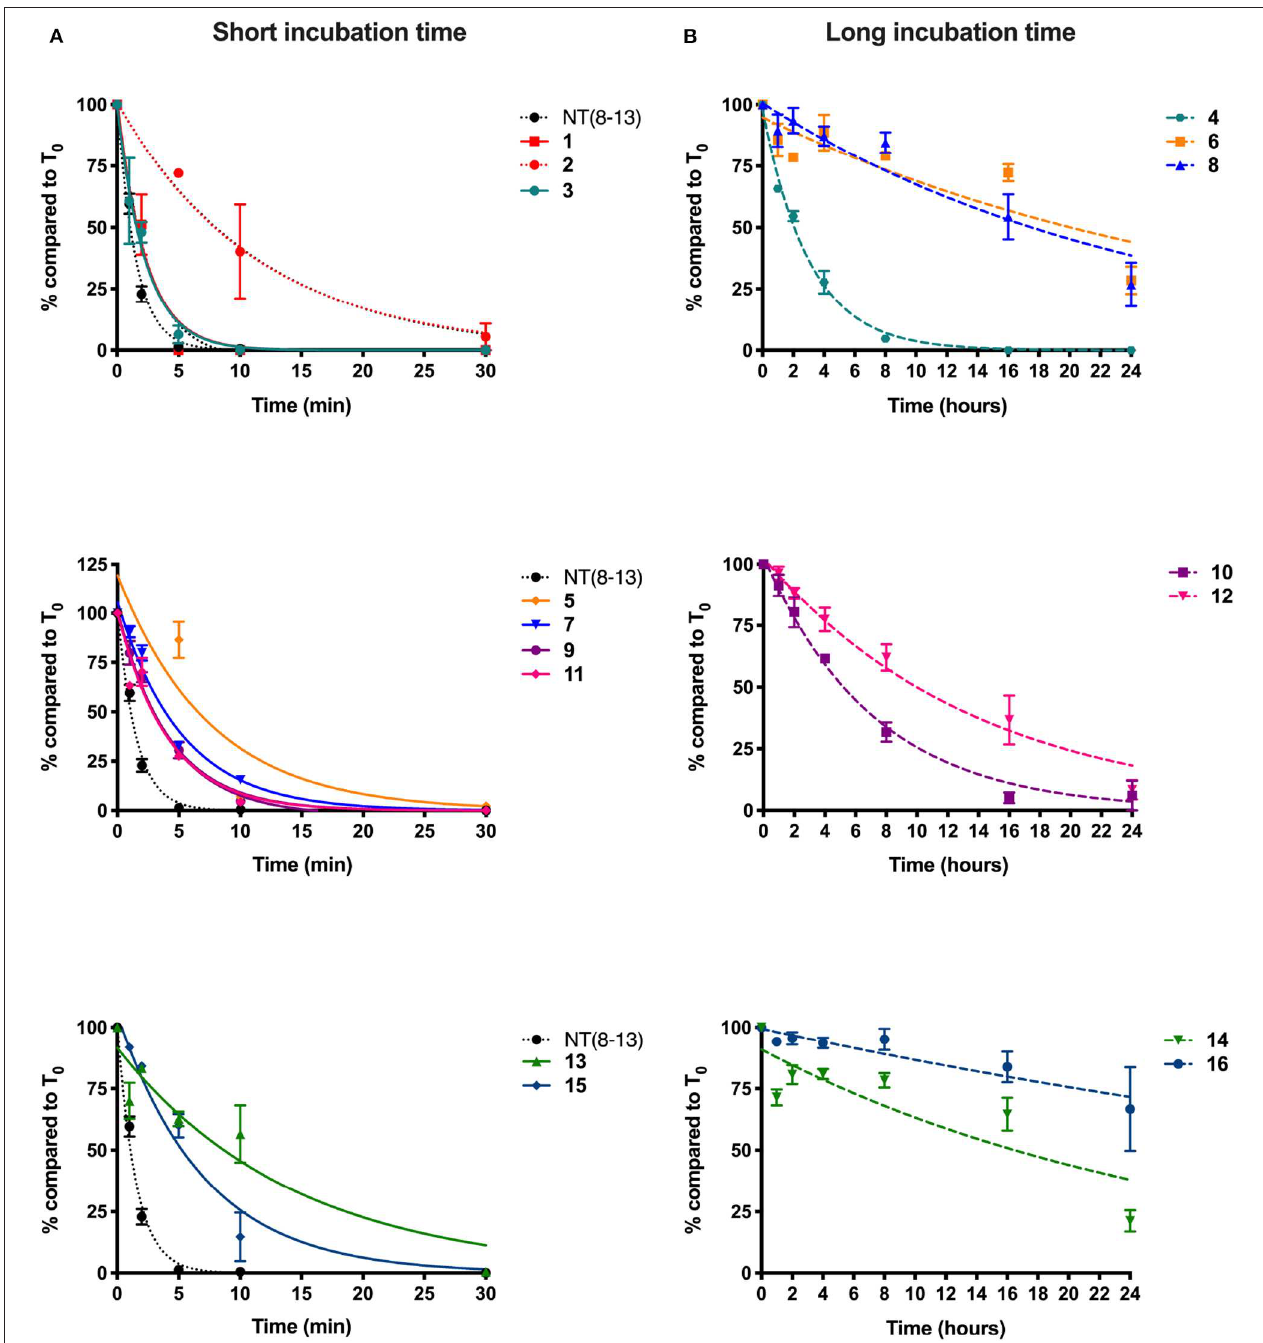
FIGURE 2 | Plasma stability of novel derivatives of NT(8-13). Compounds without reduced Lys 8 -Lys 9 pseudopeptide bond were tested for short incubation times (A) , while NT(8-13) analogs carrying reduced amine bonds were evaluated during longer time periods (B) . Determination of the percentage (%) of compounds at different incubation times in rat plasma. Half-life was calculated for each chemically modified peptide. Error bars represent mean ± SEM of at least three separate experiments for each compound.